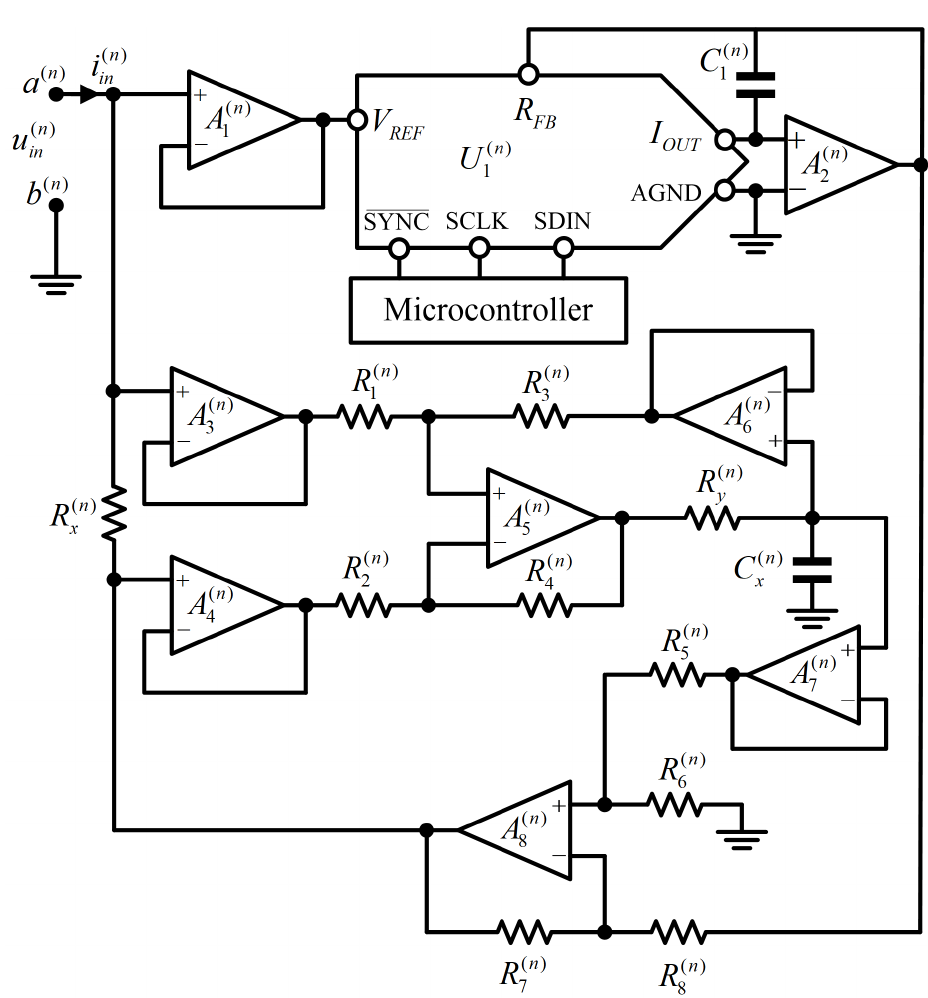
Figure 2. Circuit schematic of the n -th programmable resistor–capacitor series circuit emulator ( n = 2,3, . . . , k